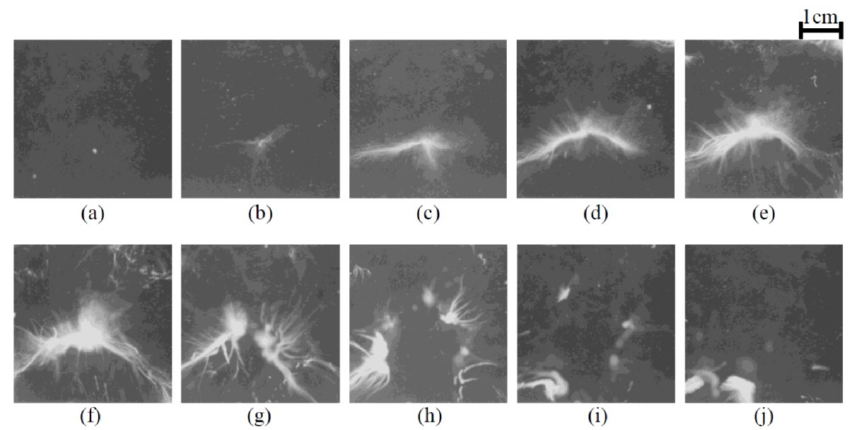
Figure 31. Photographs of cavitation bubbles taken with the still camera with the exposure of 2 ms at 23 kHz for the FG outputs of ( a ) 100, ( b ) 200, ( c ) 300, ( d ) 500, ( e ) 600, ( f ) 700, ( g ) 900, ( h ) 1000, ( i ) 1100, and ( j ) 1200 mV p-p , respectively [69]. Copyright 2001, with the permission from IOP Publishing.